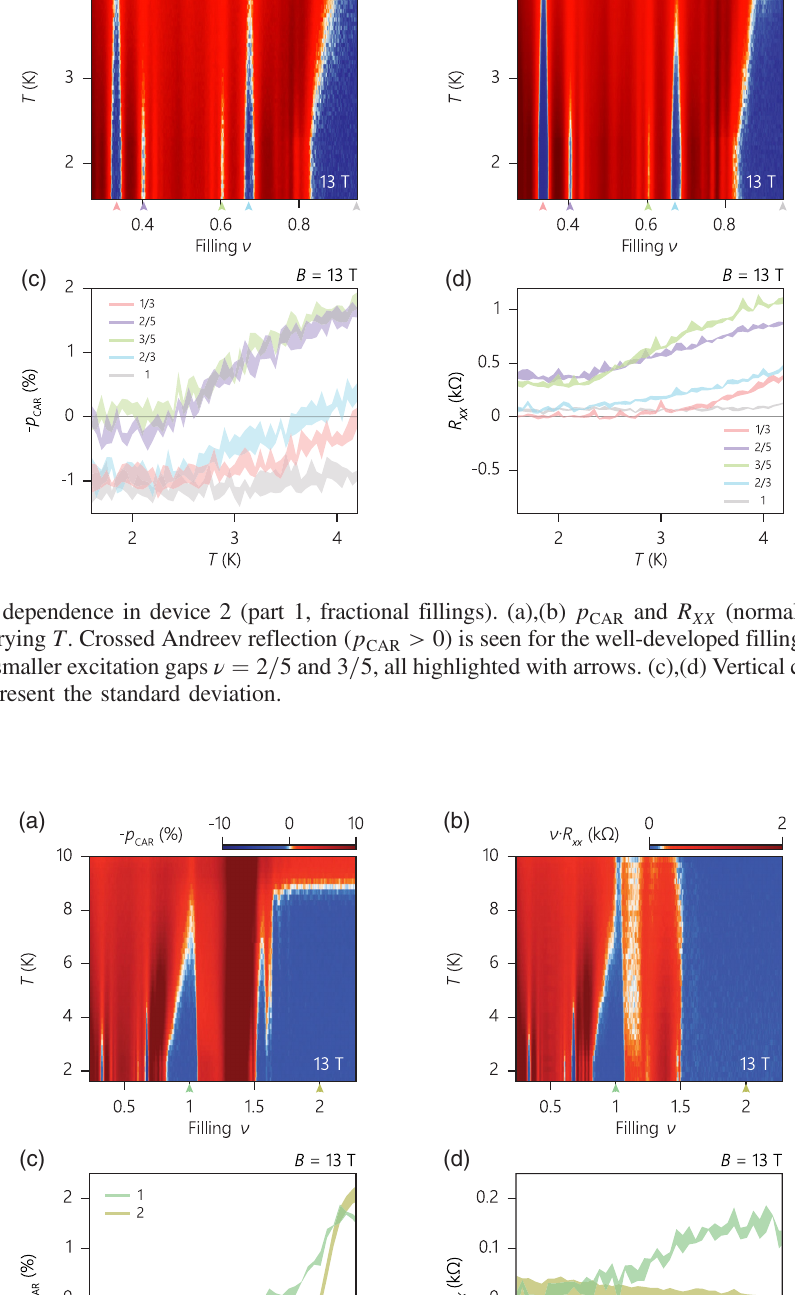
and R (normalized for different ν ) as a function XX CAR > 0 ) is seen for both integer fillings ν ¼ 1 and 2. (c),(d) Vertical cuts, CAR